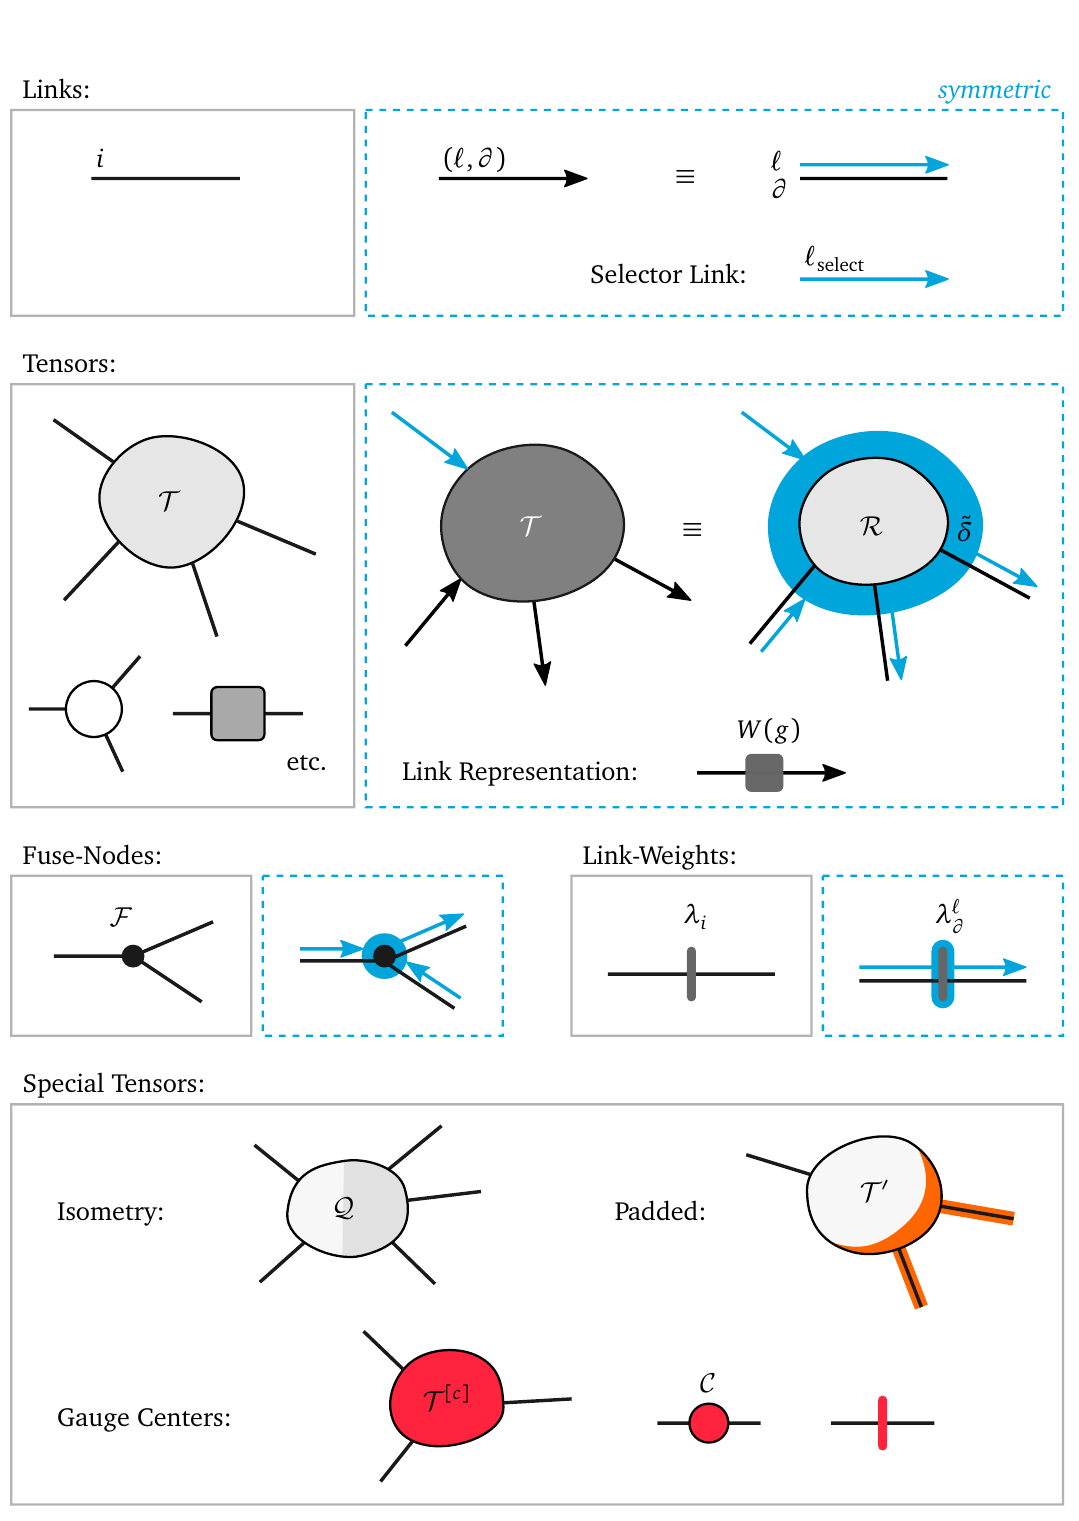
Figure 56: Graphical notation legend. Pictorial symbols for links, tensors, their symmetric counterparts, and special properties (such as isometry) are